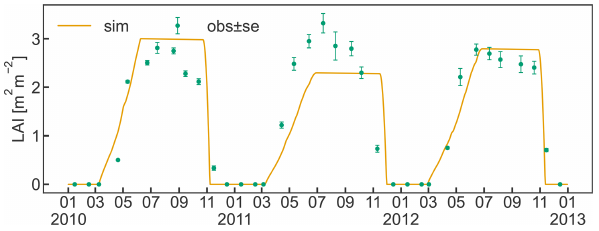
Figure 5. Simulated daily leaf area index (LAI) between 2010 and 2012 together with observations ( ± standard error) of LAI that were made once a month for the same period. Ticks on the x axis refer to the beginning of the